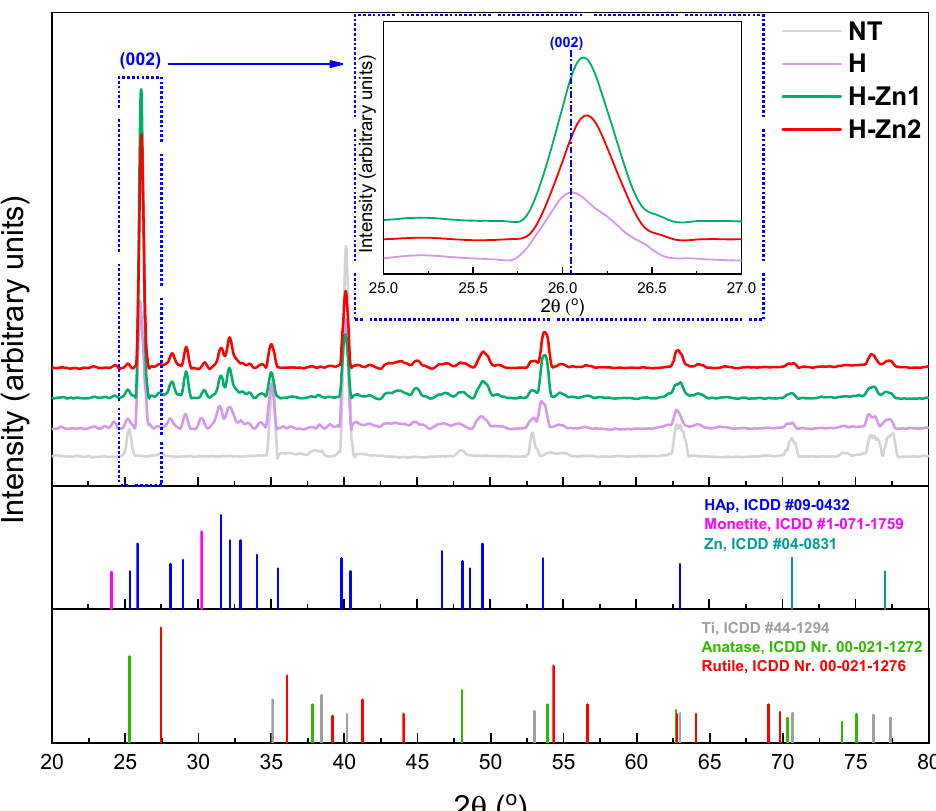
Figure 4. XRD patterns of the undoped and doped HAp based coatings.